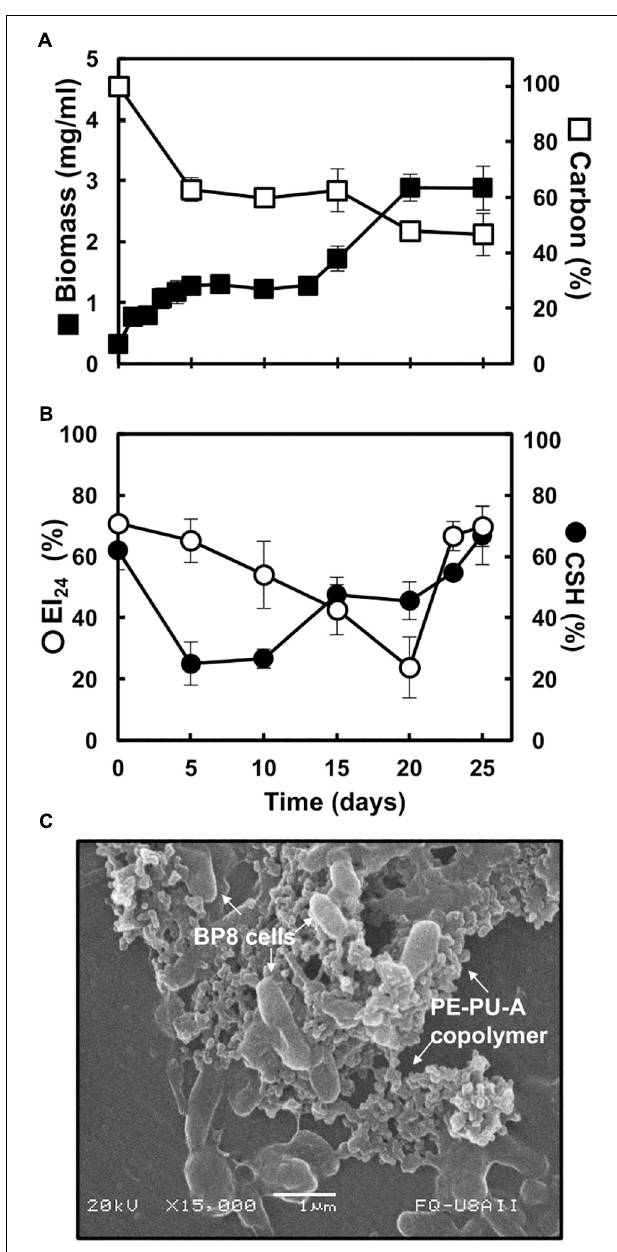
FIGURE 1 | Characteristics of the BP8 community growing in MM-PolyLack. (A) Growth and carbon consumption, (B) emulsification index (EI 24 ) and cell surface hydrophobicity (CSH) at different cultivation times. (C) SEM micrograph of BP8 cells attached to the PE-PU-A copolymer at 10 days of cultivation. Bars represent standard deviation. n =